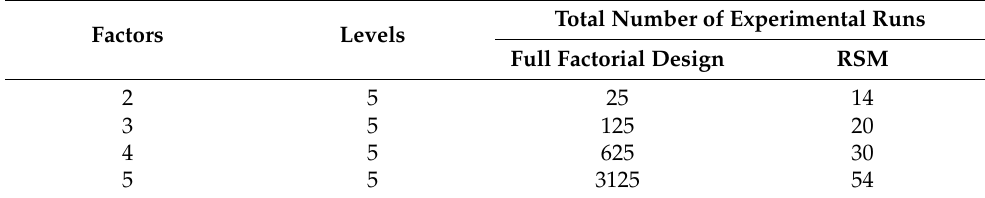
Table 2. Total number of experimental runs for full factorial design and RSM based on five-level